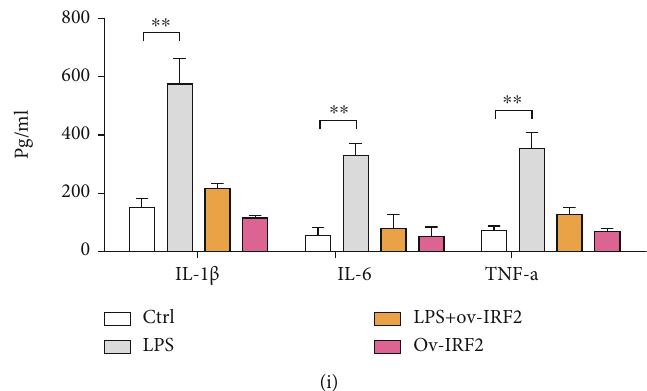
Figure 4: miR-221/222 directly targets IRF2. (a) Predictive targets of miR-221/222 from three independent databases (TargetScan, miRDB, and miRBase). (b) IRF2 protein expression in BV2 microglia after transfection of miR-221 and miR-222 mimics was analyzed by Western blotting; β -actin was loaded as a control. (c) Modeling miR-221 target sequences in 3 ′ -UTR of IRF2; a mutant 3 ′ -UTR with substitutions in the complementary site for the seed region of IRF2 was used. (d) BV2 cells were transfected with luciferase reporter vector (IRF2-WT or IRF2-Mut) and miR-221 mimics, and luciferase reporter activity was measured after transfection for 48 h. (e) Modeling miR-222 target sequences in 3 ′ -UTR of IRF2; a mutant 3 ′ -UTR with substitutions in the complementary site for the seed region of IRF2 was used. (f) BV2 cells were transfected with luciferase reporter vector (IRF2-WT or IRF2-Mut) and miR-222 mimics, and luciferase reporter activity was measured after transfection for 48h. (g) IRF2 protein expression in BV2 microglia after LPS stimulation and/or transfection with pcDNA3.1-IRF2 was analyzed by Western blotting; β -actin was loaded as a control. (h) The e ff ects of IRF2 overexpression on the mRNA expression of in fl ammatory genes ( Il1b , IL6 , Tnf , Ptgs2 , and Nos2 ) in LPS-primed BV2 cells were determined by real-time qPCR analysis ( n = 3 ). (i) The e ff ects of IRF2 overexpression on the level of in fl ammatory cytokines (IL-1 β , IL-6, and TNF- α ) in conditioned medium from LPS-primed BV2 cells were analyzed by ELISA ( n = 3 ). ∗ p < 0 : 05 , ∗∗ p < 0 : 01 , and ∗∗∗ p < 0 : 001